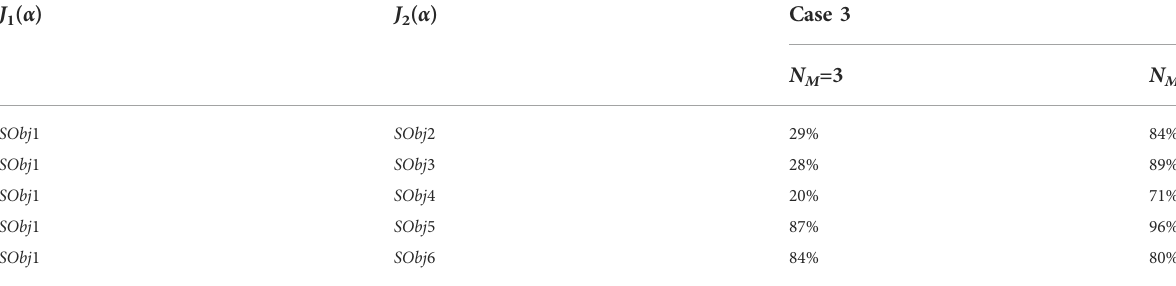
TABLE 3 DVC100 values of SDD results in case 3 based on w =